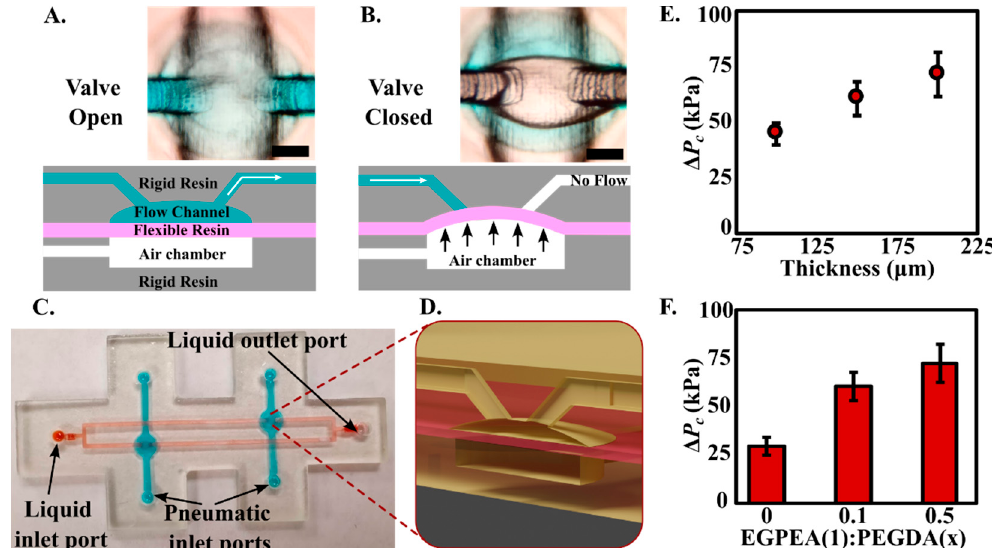
Figure 6. Top view (chip valve image) and side view (illustration) of the flexible pneumatic valve sandwiched between rigid flow channel and rigid compressed air chamber in the ( A ). valve open and ( B ). valve close sates (scale bar = 300 μ m). ( C ). 3D printed Microfluidic chip incorporating separate inlet port, outlet port, channels for the liquid flow, and compressed air lines. ( D ). 3D blowout of the pneumatic valve illustrating the location of the flexible membrane (in red). Variation of valve closing pressure as a function of ( E ). membrane thickness and ( F ). resin composition.